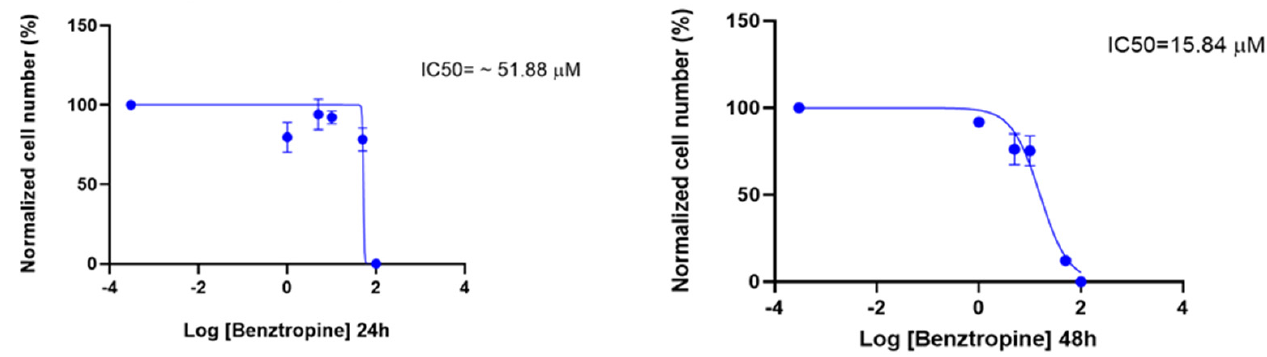
Figure 16. Comparison of the cell viability (% of control) between 24 h and 48 h of exposure.